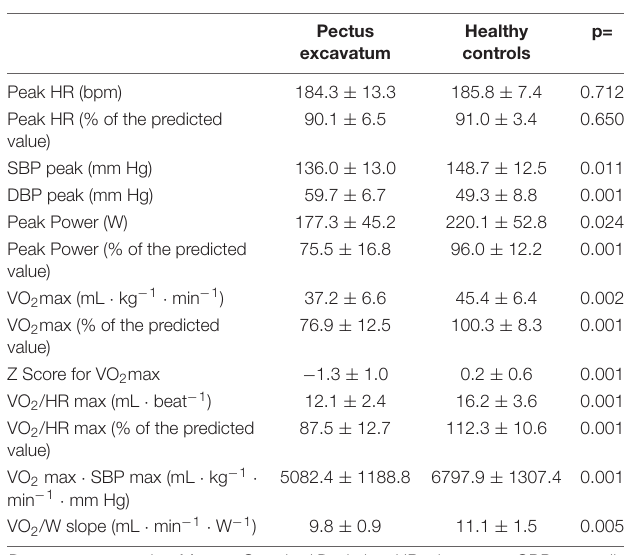
TABLE 3 | Cardiopulmonary Exercise Testing Data.